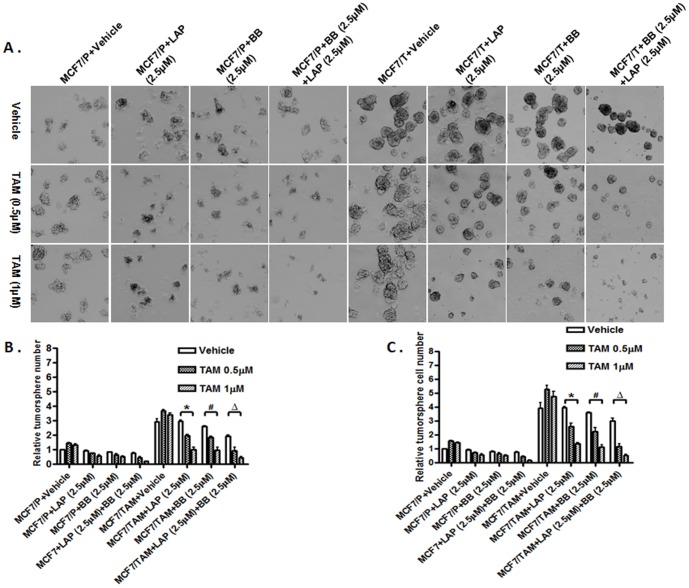
Combination of Broussoflavonol B and Lapatinib sensitizes ER-positive breast cancer stem/progenitor cells to TAM.A. Tumorsphere formation assay was used to assess the effects of TAM alone or together with 2.5 µM of Lapatinib (LAP), Broussoflavonol B (BB) or BB (2.5 µM) and LAP (2.5 µM) on ER-positive breast cancer stem/progenitor cells derived from parental MCF7 (MCF7/P) and tamoxifen resistant MCF7 cells (MCF7/TAM). The representative results are shown. B. The numbers of tumorspheres formed by MCF7/P and MCF7/TAM cells in the absence or presence of LAP (2.5 µM), BB (2.5 µM) or LAP (2.5 µM) and BB (2.5 µM) together. C. The number of cells from dissociated tumorspheres formed by MCF7/P and MCF7/TAM cells in the absence or presence of LAP (2.5 µM), BB (2.5 µM) or LAP (2.5 µM) and BB (2.5 µM) together. The columns represent the means of three experiments; bars, SE. *, # and Δ, P<0.05 for MCF/TAM cells treated with vehicle vs cells treated with tamoxifen and LAP, BB, or LAP+BB together.